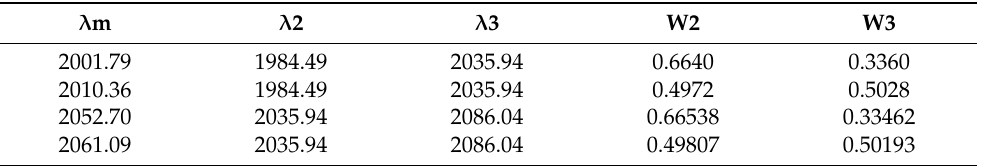
Table 2. PRISMA wavelengths to be used to derive the diverse CO 2 -continuum interpolated band ratio (CIBR) PRISMA. λ m λ